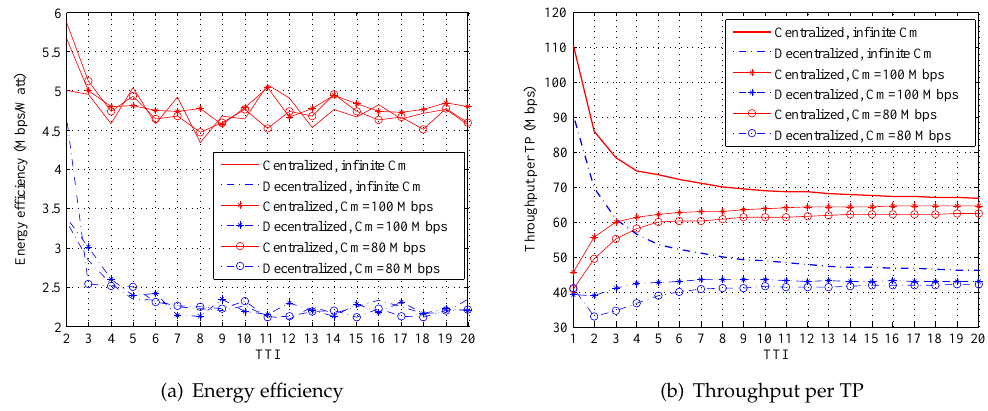
Figure 7. System performance under different backhaul capacity (20 Watts, R thres = 360